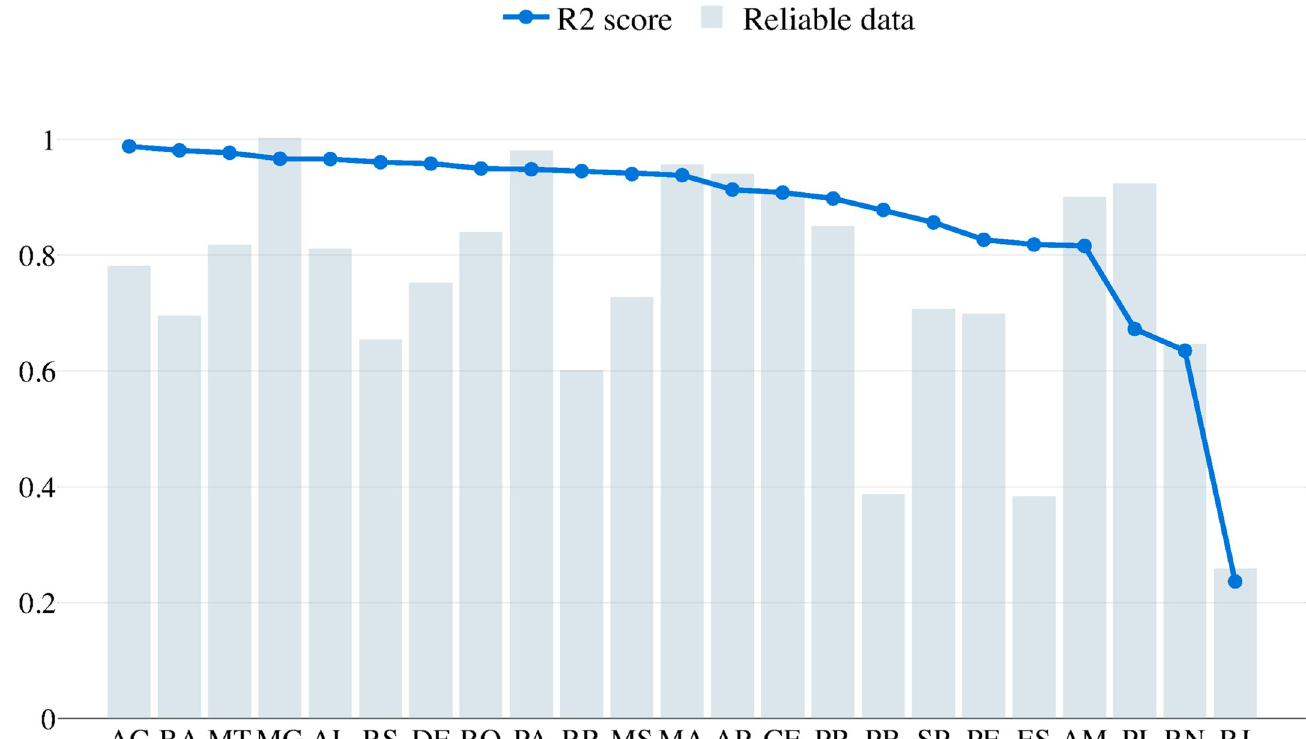
Fig 2. R 2 value comparing the predictions with the real data of each state and the reliability metric that shows the proportion of the data that is reliable to use on the learning algorithm.